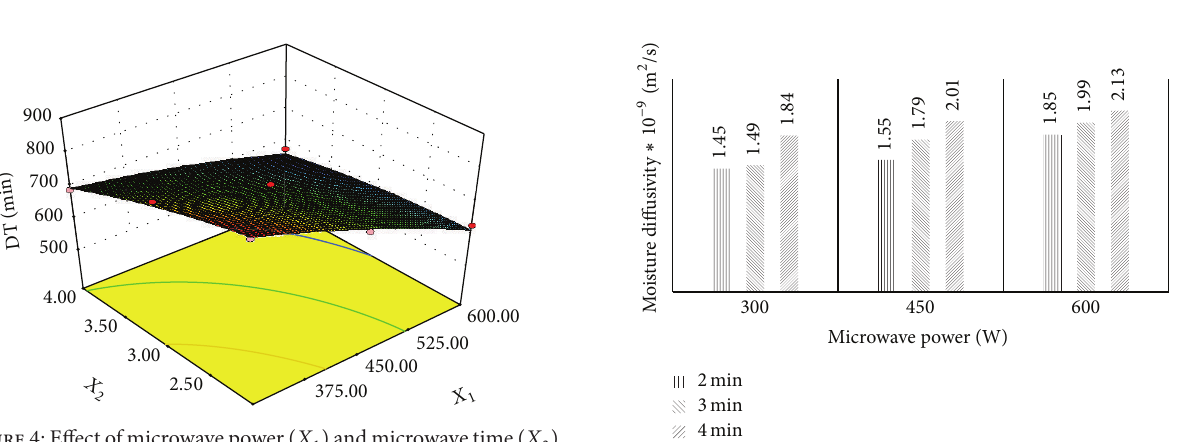
Figure 4: Effect of microwave power ( 𝑋 1 ) and microwave time ( 𝑋 2 ) on drying time. Figure 5: Effect of microwave power and time on moisture diffusiv- ity of mango